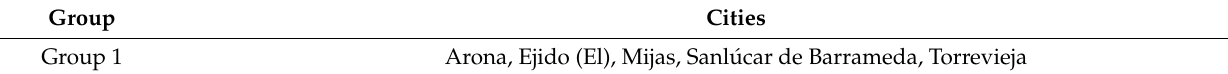
Table 2. Classification of cities by net